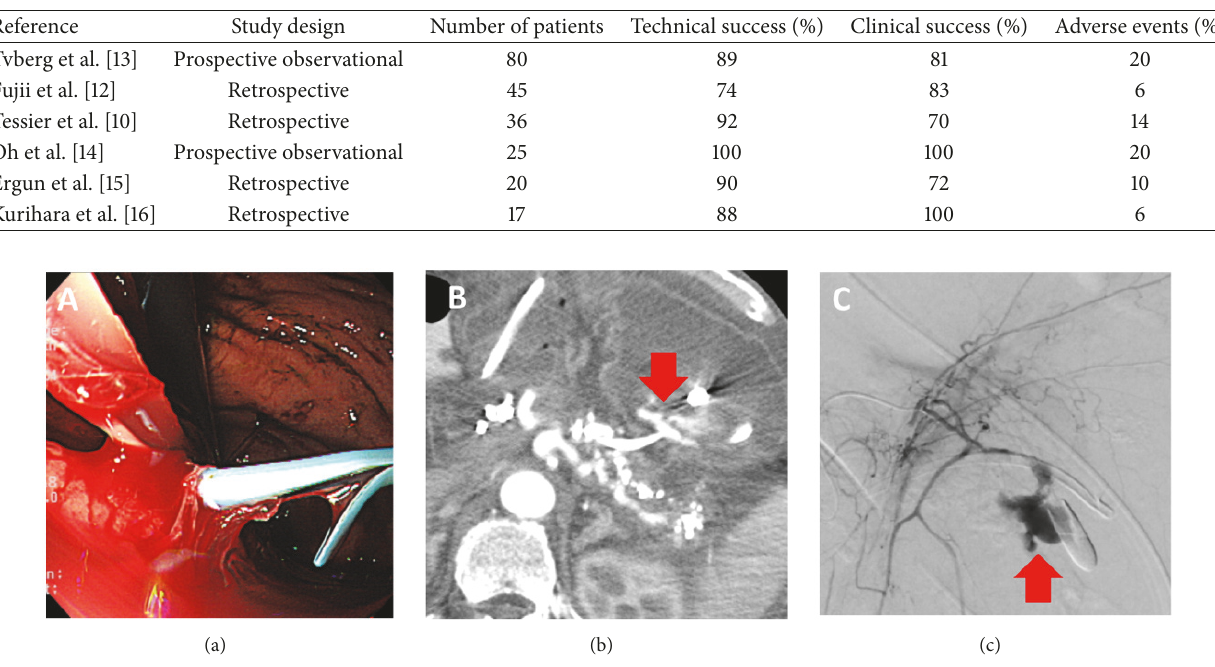
Table 2: Results of previous studies performed on EUS-PD.